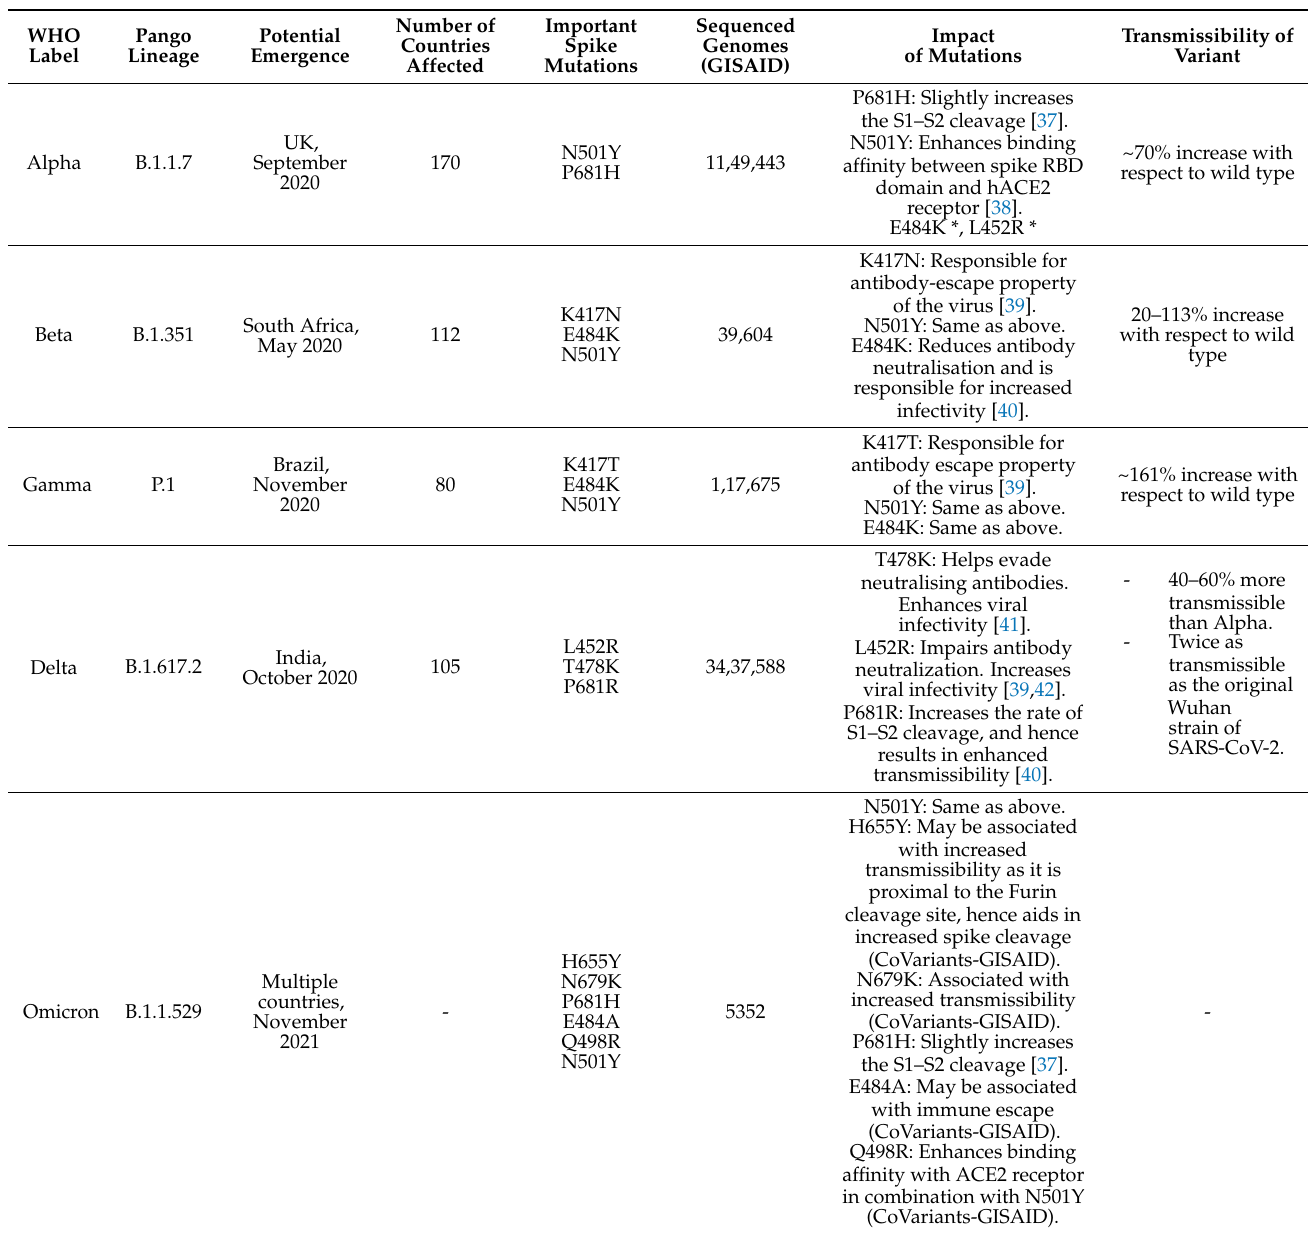
Table 1. SARS-CoV-2 variants of concern (VOCs) with their date and place of emergence and important spike mutations, along with their effect on the variant’s overall